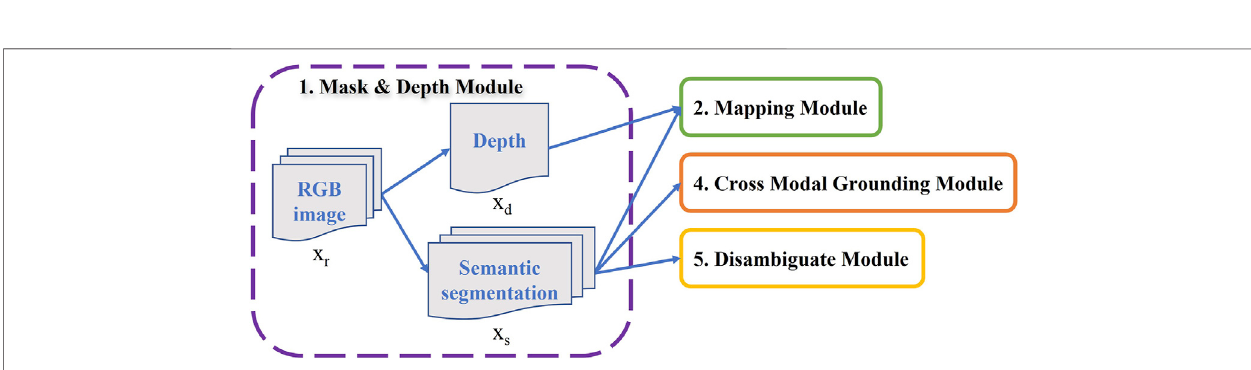
FIGURE 2 | MoViLan overview: All six modules are shown in boxes. Arrows show how modules transfer information to achieve a set of actions (Pick up here).